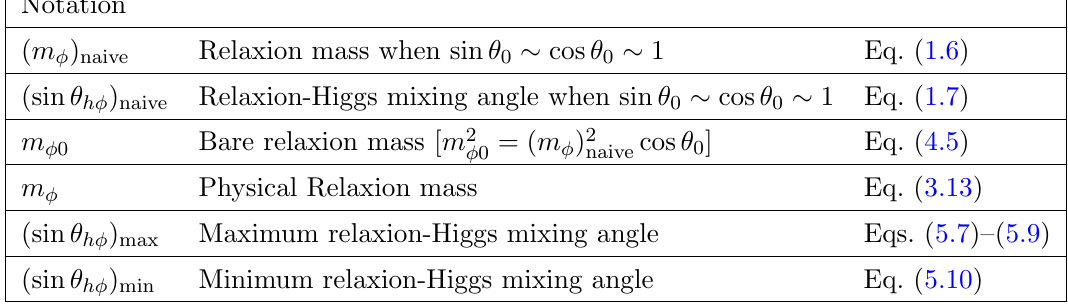
Table 1 . Glossary. Here (cid:18) 0 = (cid:30) 0 =f denotes the (cid:12)eld value at a local minimum. The parameters with subscript \naive" indicate the quantity when sin (cid:18) 0 the discussions around the quoted